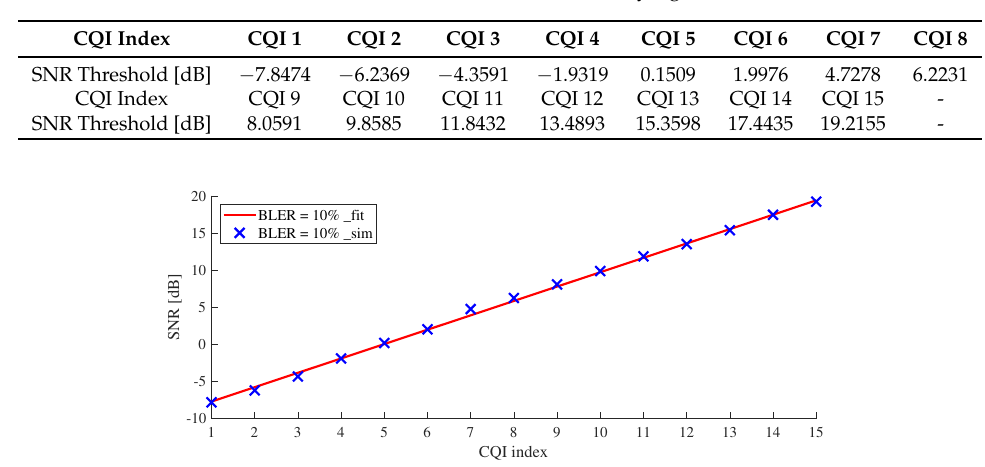
Table 5. The values of SNR Threshold satisfying 10% BLER.